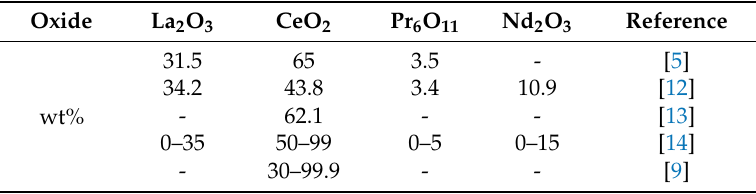
Table 2. Chemical composition of different glass polishing